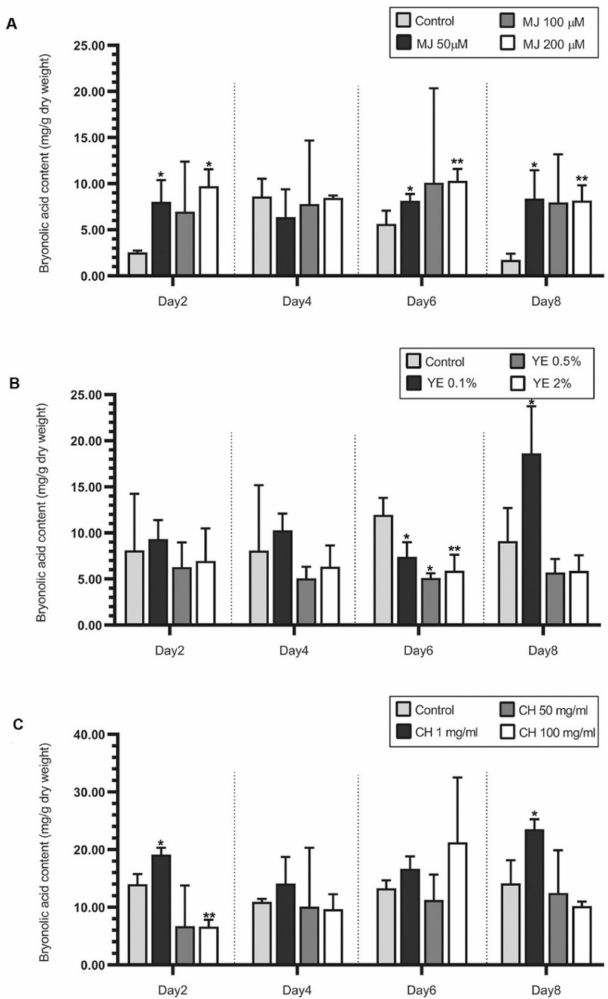
Figure 3. E ff ects of elicitors on bryonolic acid production in TC cell suspension cultures. ( A ) Methyl jasmonate (50, 100, and 200 µ M), ( B ) yeast extract (0.1, 0.5, and 2% w / v ), and ( C ) chitosan (1, 50, and 100 mg / mL). Elicitors were added to four-week cell suspensions, which were observed after treatment for 2, 4, 6, and 8 days compared with controls (70% ethanol, sterile water, or 1 N acetic acid, respectively). Data are presented as the mean from three independent cell lines, and error bars show the standard deviations. The asterisk indicates significance (* p -value < 0.05, ** p -value < 0.01 compared with control group by t -test from Microsoft Excel